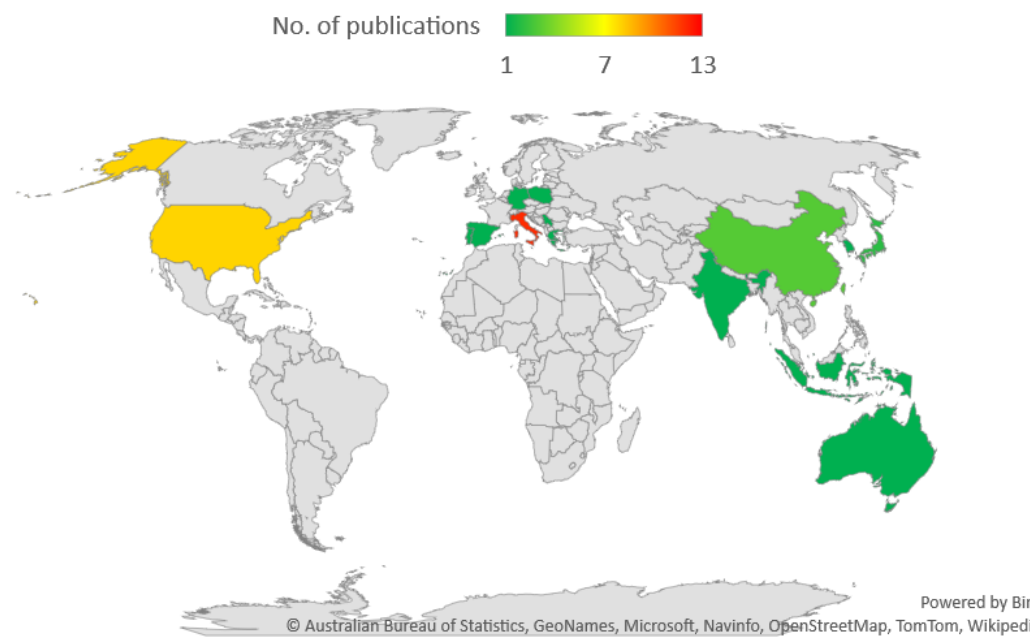
Figure 9. Distribution of the articles associated with low-cost structural building monitoring.